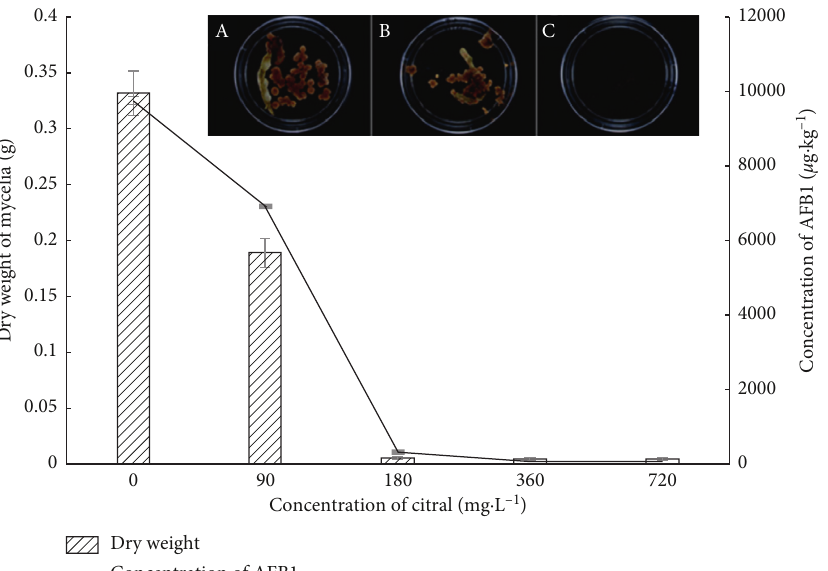
Figure 3: Inhibitory effect of citral on growth and toxicity of A. flavus 3.4408. ∗ A: control (untreated); B: citral at 90mg L − 1 ; C: citral at 180mgL − 1 .